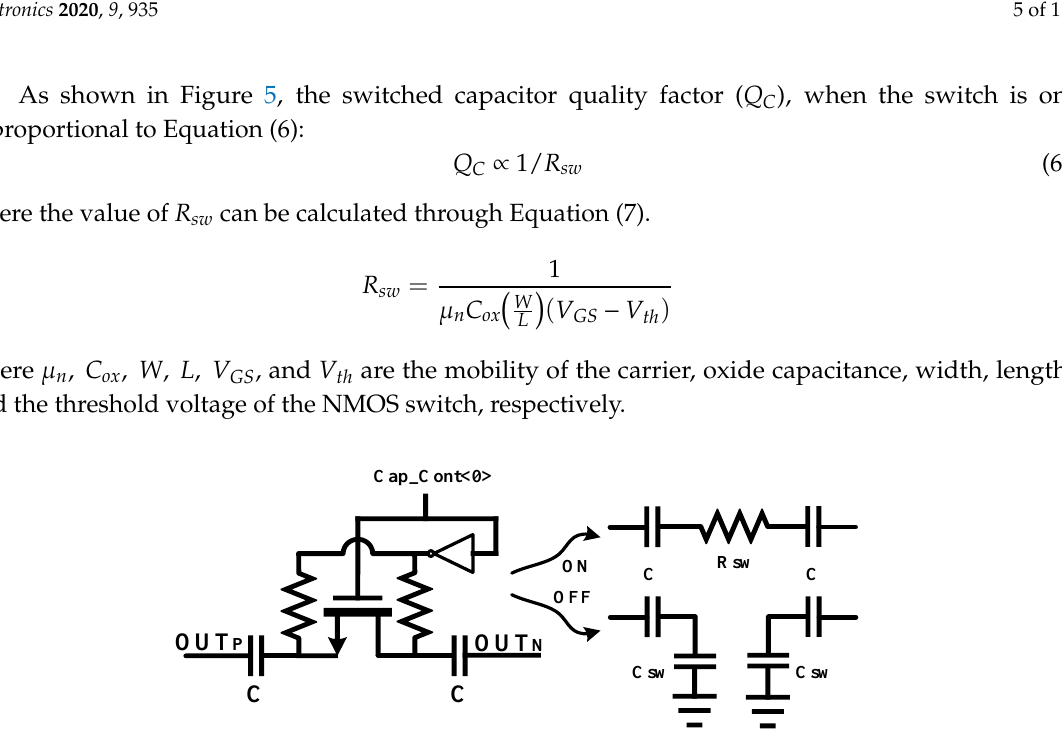
Figure 5. Switch capacitor equivalent circuit in off and on cases of switch.